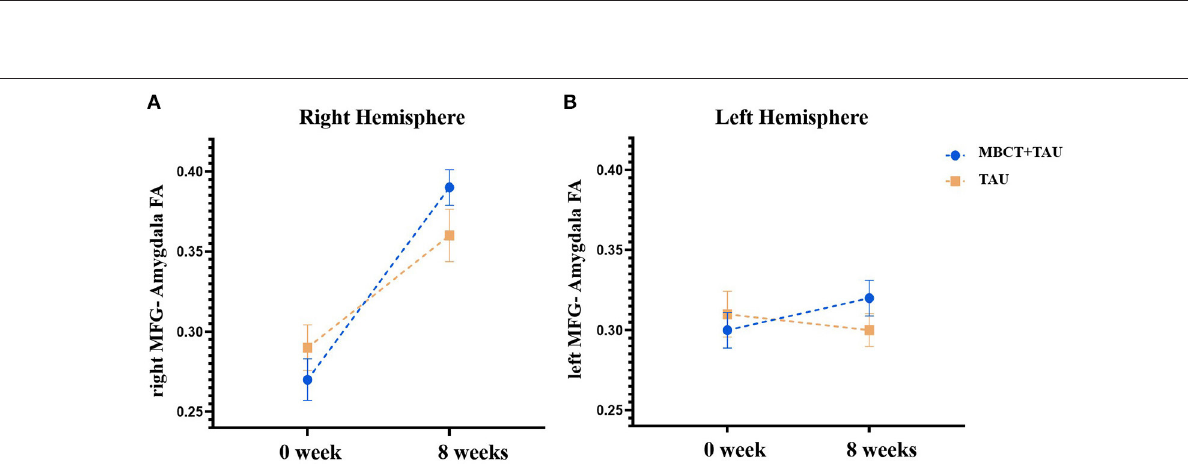
Frontiers in Psychiatry |